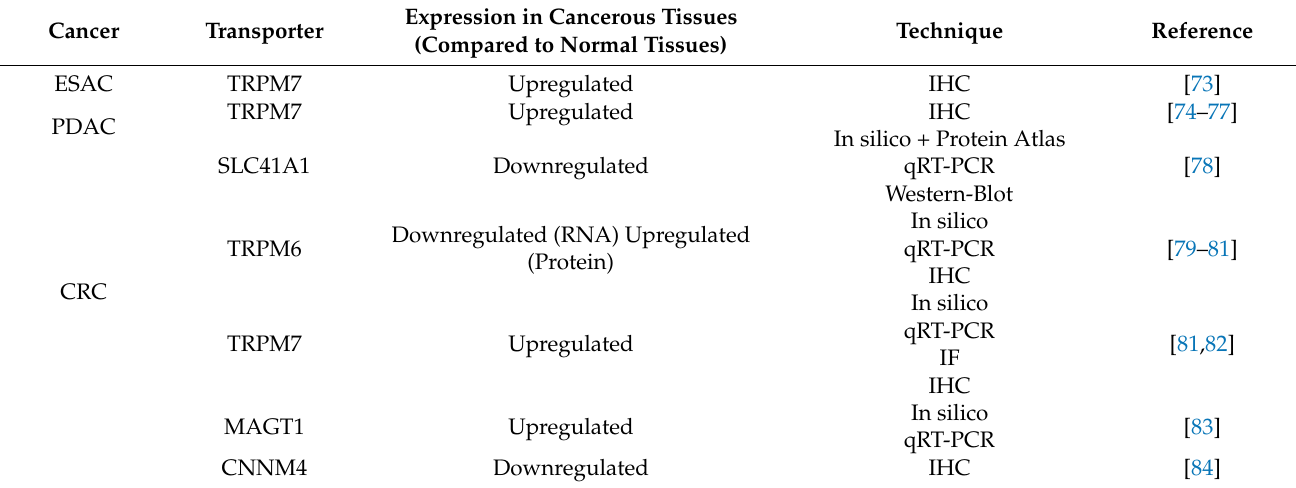
Table 1. Expression of Mg 2+ Transporters in Digestive Cancer